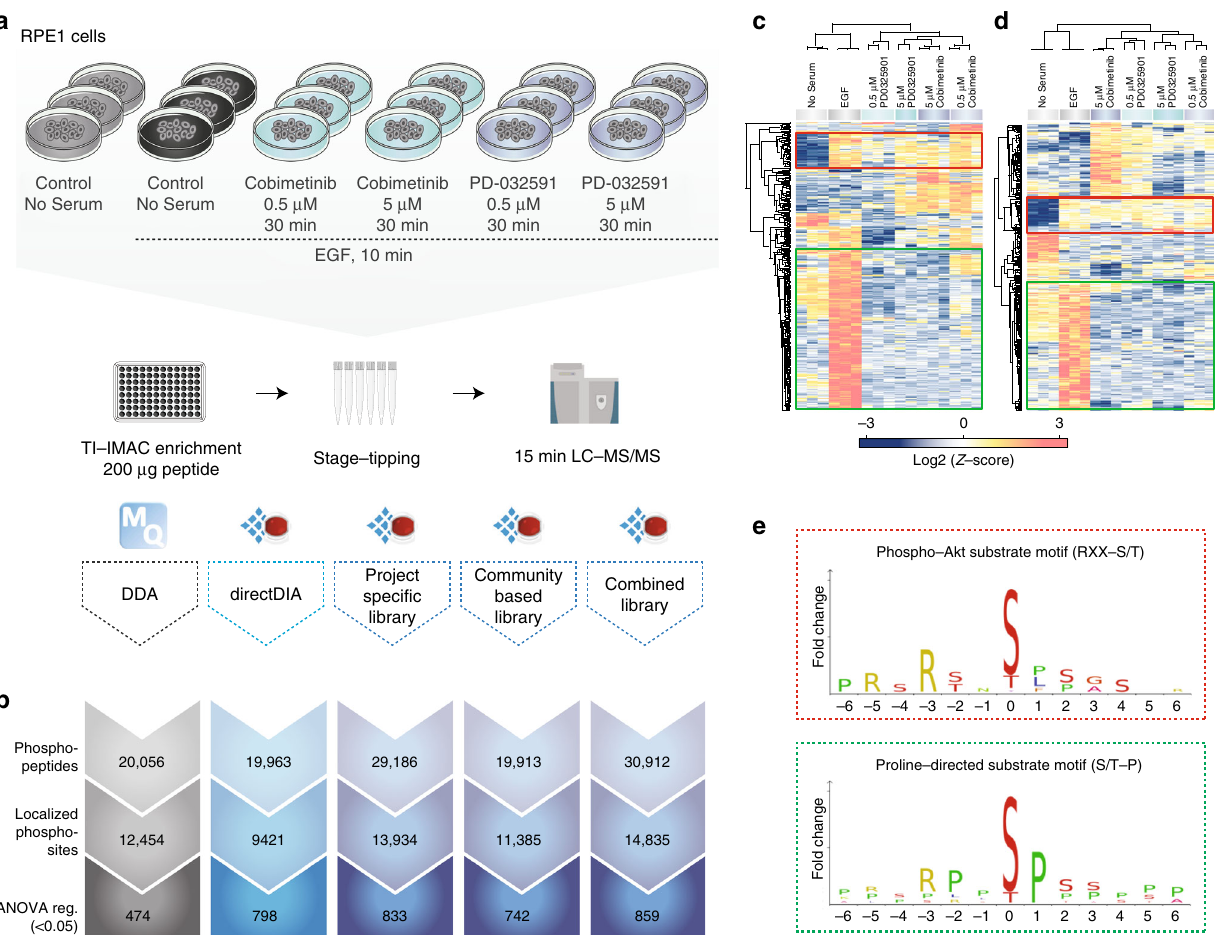
Fig. 3 Technical comparison of DDA and different types of DIA in a biological setting. a Experimental work fl ow. b Overview of identi fi ed phosphopeptides, localized phosphosites, and ANOVA ( s 0 = 0.1, FDR 0.5) regulated sites for the different methods. c Heatmap of unsupervised clustering analysis of ANOVA-regulated phosphosites for DDA work fl ow ( d ) and for DIA work fl ow with project-speci fi c library ( e ). Linear sequence motif analysis for two major clusters marked in colored boxes on heatmaps. All data are shown for three independent